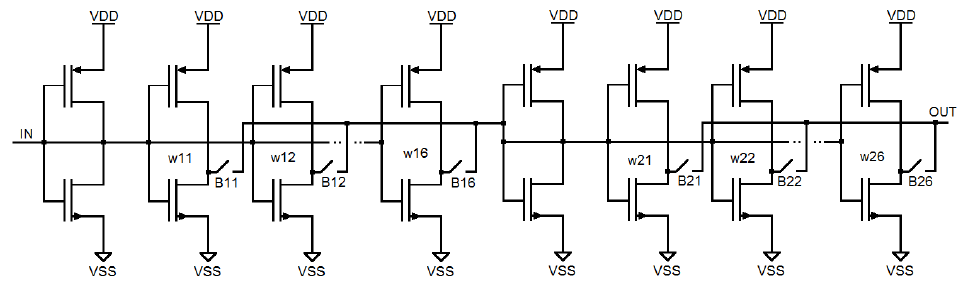
Figure 1. Circuit that implements the weight of the neuron [43].